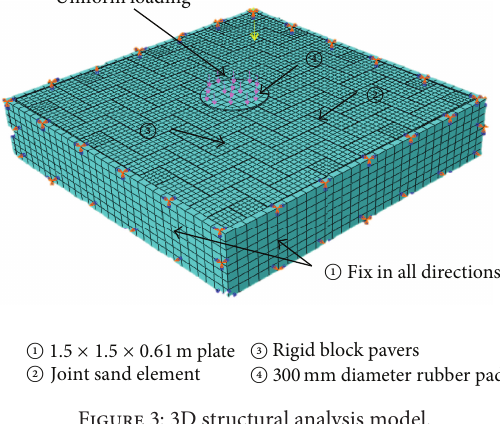
Figure 3: 3D structural analysis model.